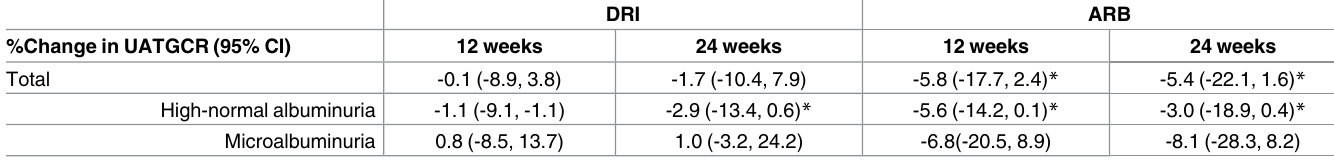
CI: confidence interval, UATGCR: urinary angiotensinogen-to-creatinine ratio The values represent the mean (inter-quartile range). * p < 0.05 vs. baseline No significant differences were found between the treatment